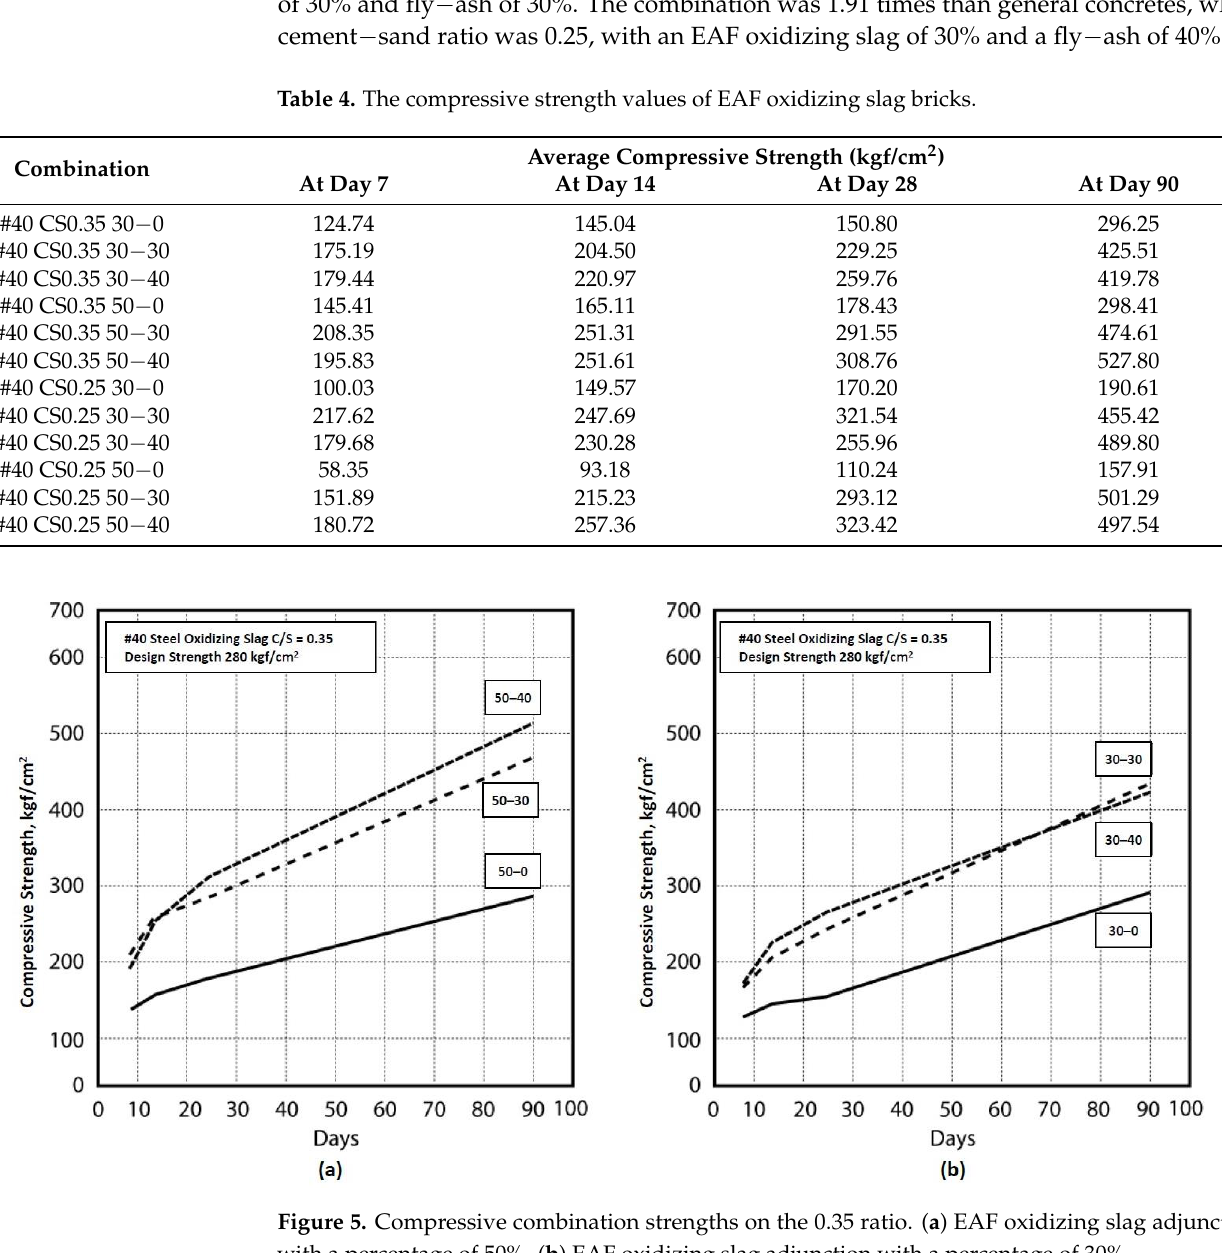
Table 5. Water absorption of EAF oxidizing slag bricks.